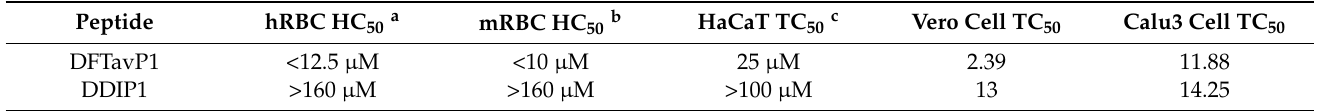
Table 3. Cytotoxicity comparison of antiviral peptides to different